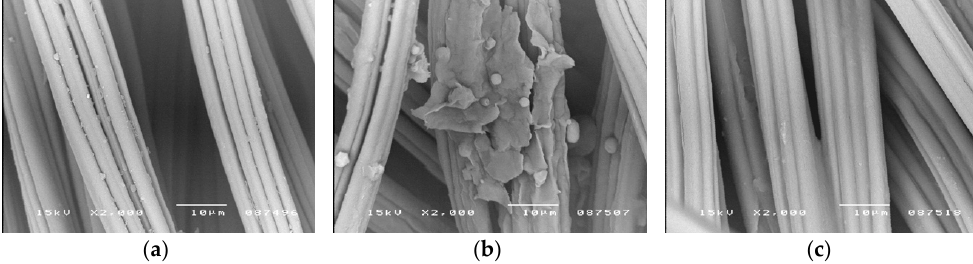
Figure 3. SEM images of viscose fibers surface before and after fabric modification (magnification 2000×); ( a )—Control sample (before modification); ( b )—After impregnation with beeswax suspension and drying at room temperature; ( c )—sample B after heat treatment at 120 °C for 1 min.